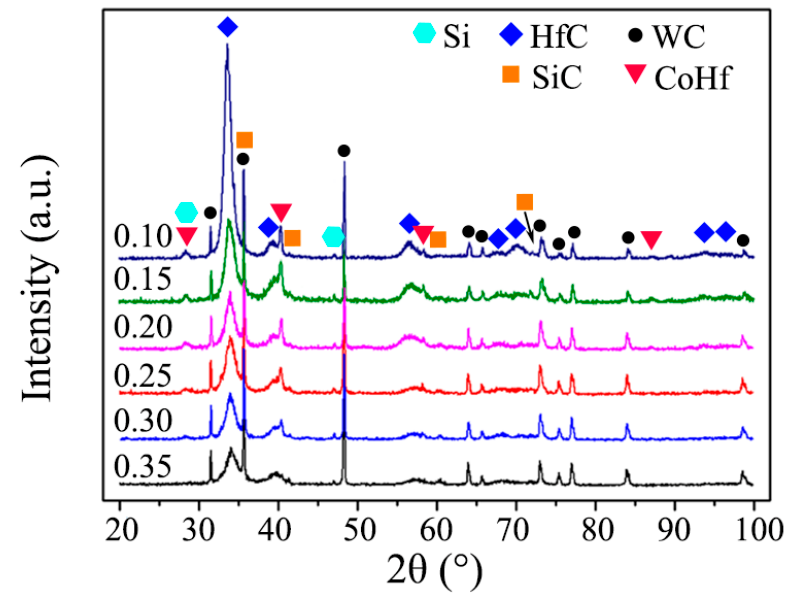
Figure 4. XRD patterns of the bi-interlayers deposited with different TMS flow rate increment.